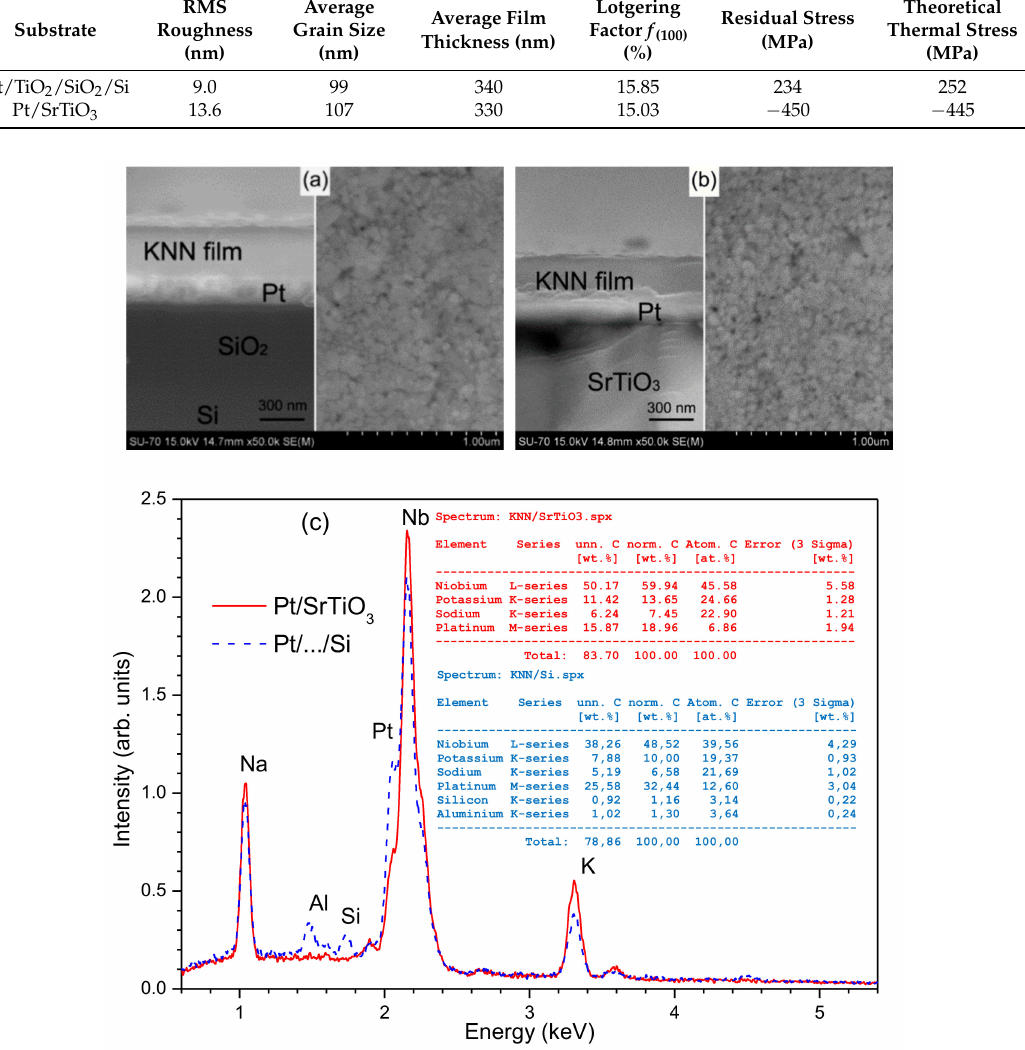
Figure 3. Cross-section (left) and top-view (right) SEM micrographs of KNN films on Pt/TiO 2 /SiO 2 /Si ( a ) and Pt/SrTiO 3 ( b ) substrates, as well as their energy-dispersive spectra with quantifications ( c